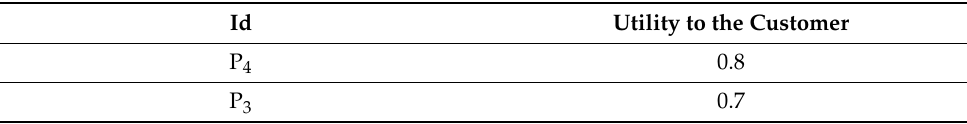
Table 12. Ranked list of PSS variants based on their utility to the customer.